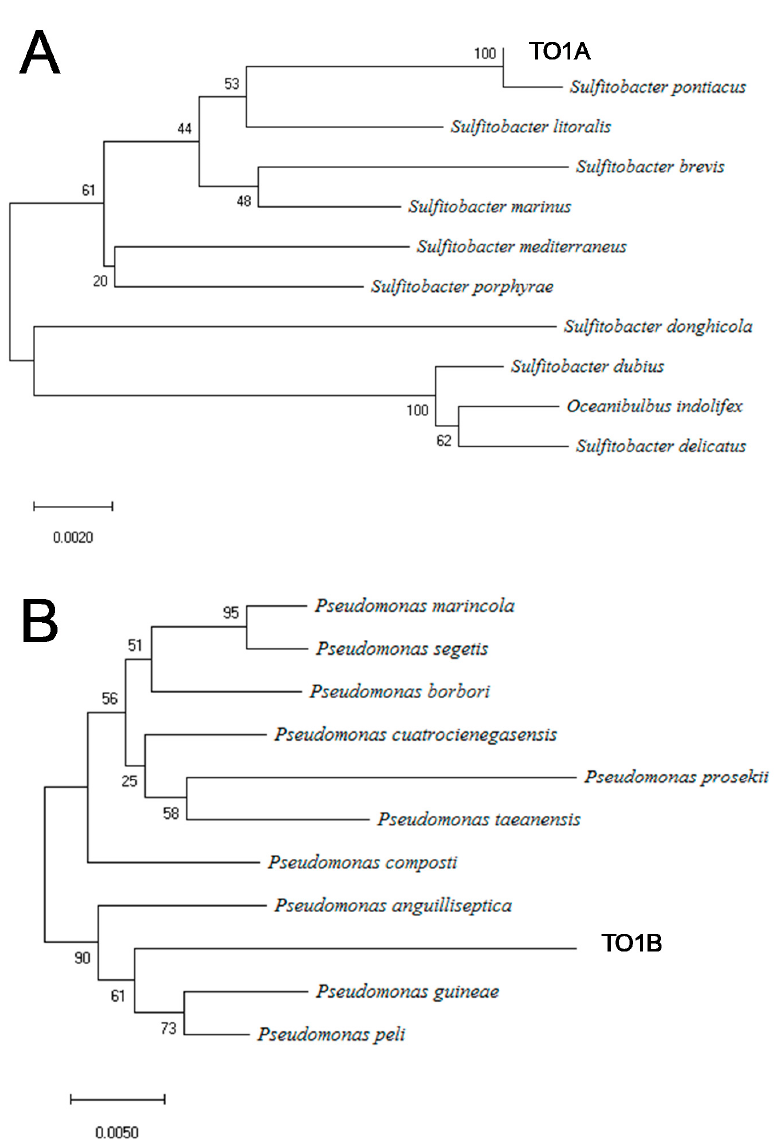
Figure 3. Phylogenetic trees of TO1A and TO1B using 16S rRNA sequences. ( A ) Strain TO1A was identified as Sulfitobacter sp. (accession numbers are in Table S4). ( B ) Strain TO1B was identified as Pseudomonas sp. (accession numbers are in Table S5).